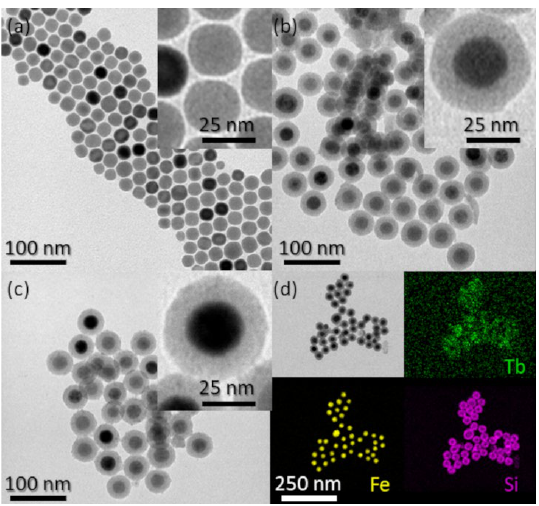
Figure 2. TEM images of: ( a ) IONP/OA/OA, ( b ) IONP@SiO 2 - acac , and ( c ) IONP@SiO 2 - acac /Tb 3+ /Eu 3+ . ( d ) STEM-Bright Field image (BF) and STEM-EDX elemental mapping of IONP@SiO 2 - acac /Tb 3+ /Eu 3+ with topochemical distribution of Tb (green), Fe (yellow), and Si (pink). IR spectra of nanoparticles synthesized in all steps are shown in Figure S4, Support- ing Information. The IR spectrum of sample IONP@SiO 2 clearly indicates the formation of Si) and ν(Si -OH) in the 700–1400 cm −1 spectral window. Moreover, the bands assigned to the free and coordinated to Ln 3+ acac ligand may be observed on the IR spectra of samples IONP@SiO 2 and IONP@SiO 2 - acac /Tb 3+ /Eu 3+ , respectively (Figure S4, Table S2, SI). How- ever, due to the low intensity of the characteristic bands of the acac ligand and their over- lapping with the bending vibrations of the OH groups from water, it was not possible to clearly state on the coordination of the lanthanide ions to the acac ligand in IONP@SiO 2 - acac /Tb 3+ /Eu 3+ . TEM images of samples at different stages of preparation demonstrate that each sin- gle IONP core is surrounded by a clearly determined silica shell in IONP@SiO 2 , IONP@SiO 2 - acac , and IONP@SiO 2 - acac /Tb 3+ /Eu 3+ (Figures 2b,c,d, Figure 1). The size distri- bution for the IONP@SiO 2 - acac /Tb 3+ /Eu 3+ sample indicates an IONP core size of 26.0 ± 1.8 nm and a silica shell thickness of 11.2 ± 0.3 nm (Figure S5, SI). Note that the sizes and the shape of the IONP nanoparticles have not been altered by the silica coating, ligand graft- ing, and the coordination of Ln 3+ (Figure 2, Figures S1 and S5, SI). Moreover, quasi mono- dispersed nanoparticles have been obtained in all steps (the standard deviations (SD) for all samples are less than 5% except one, for which it is less than 7%, see Figure 2c). The topochemical distribution visualized by HAADF-STEM with the EDX mapping confirms the homogeneous distribution of Si and Tb 3+ on the surface of IONP@SiO 2 - acac /Tb 3+ /Eu 3+ nanoparticles, whereas Eu 3+ could not be detected because of its very low amount (Figure 1d). This situation has already been seen in another work [9]. The DLS results (Figure S1c and S6, Supporting Information) indicate that the nanoparticles ob- tained in all steps are not aggregated.